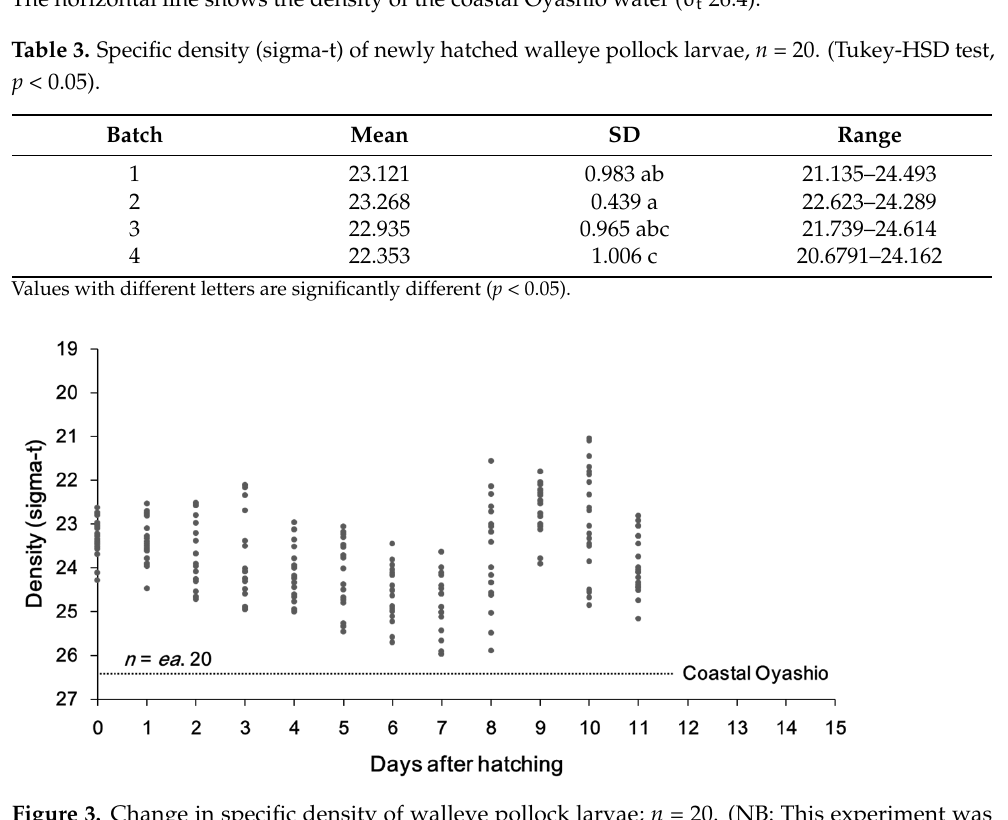
Figure 3. Change in specific density of walleye pollock larvae; n = 20. (NB: This experiment was incomplete as sufficient larvae were unavailable.) The horizontal line shows the density of the coastal Oyashio water ( σ t 26.4).